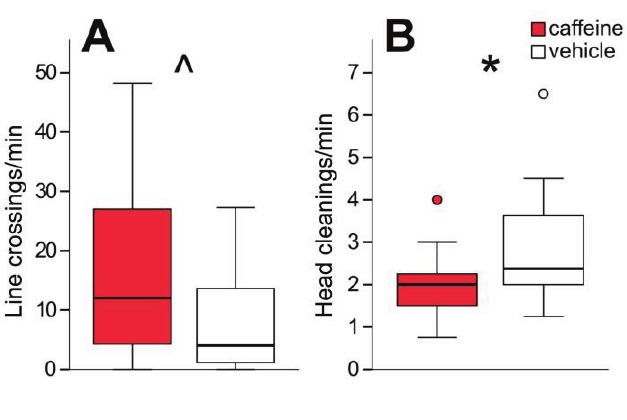
behaviour ( B ). By experiment, 7 d: n caffeine = 17, n vehicle = 16. Caffeine-treated bees had significantly fewer head cleanings per minute ( p = 0.045) and showed a trend